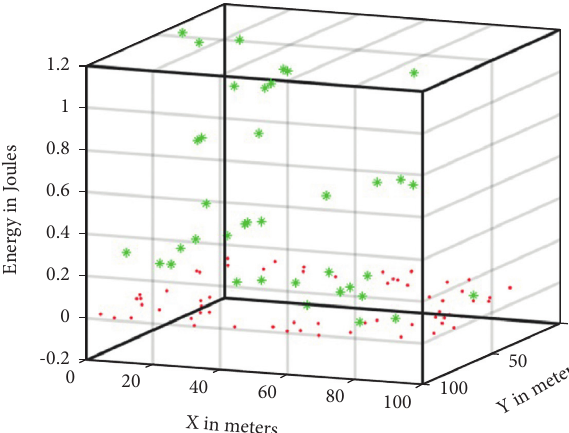
Figure 6: The residual energy of the network after 5000 rounds in 20% of heterogeneous energy of 100 nodes.